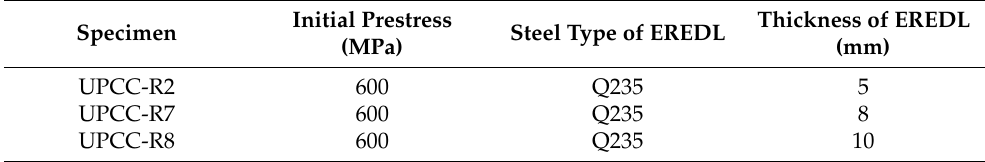
Table 12. Bridge pier working conditions under different thickness of EREDL.